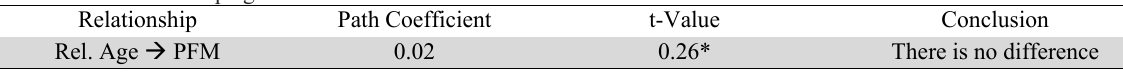
Evaluation on relationship age as moderator variable